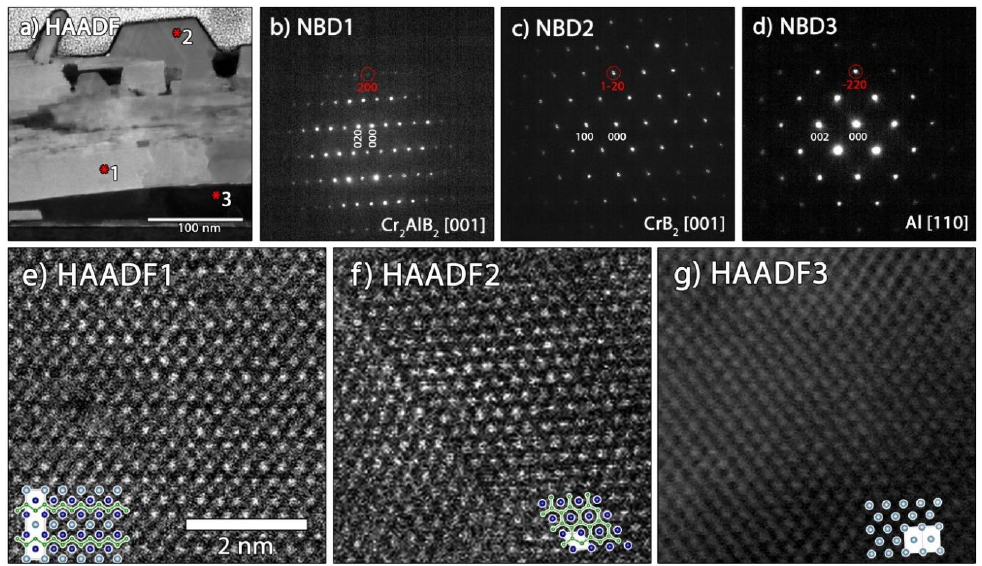
Figure 7. TEM analysis of sample B: ( a ) dark field STEM image with marked positions for structural analysis, ( b ) NBD pattern of Cr 2 AlB 2 in [001] orientation, ( c ) of CrB 2 in [001] orientation and ( d ) of Al in YYN orientation recorded at spots 1, 2 and 3, respectively, as marked in ( a ) with the reflections